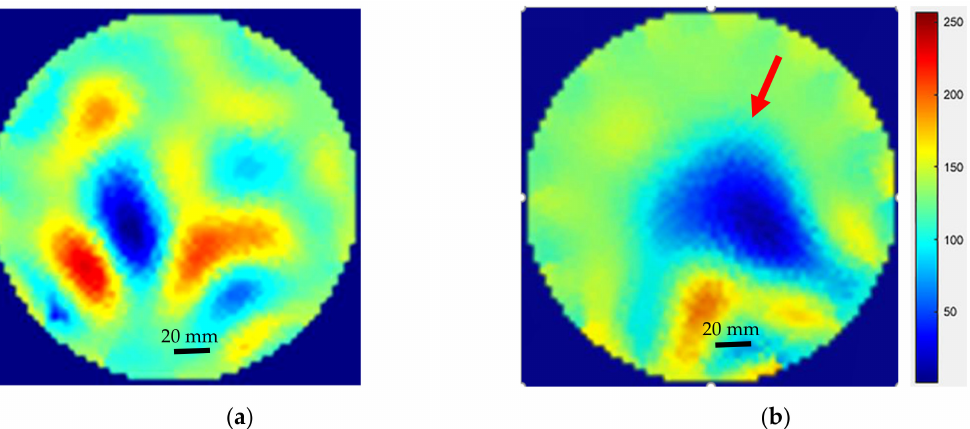
Figure 16. ( a ) Water inside reactor; ( b ) CaCO 3 insertion detected using ERT (blue region indicated by